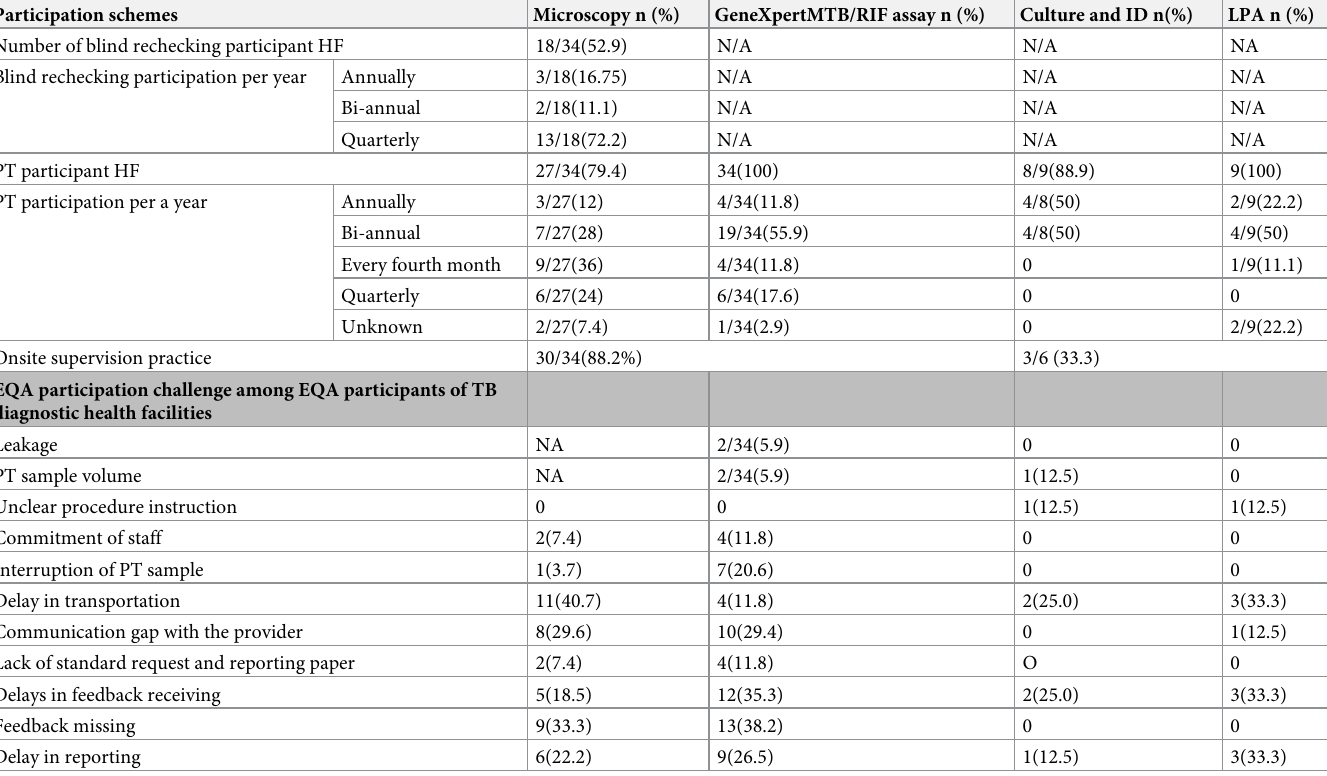
Table 4. External quality assurance practice in selected TB-diagnostic health facilities and TB-culture